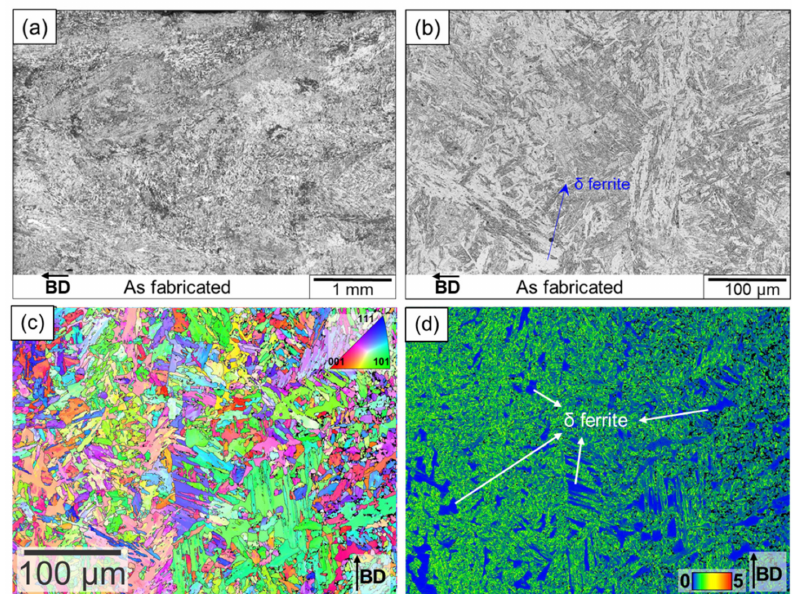
Figure 5. Characterization of the “Bottom” sample in an as-fabricated state ( a , b ). Optical micrographs showing a martensitic structure with delta ferrite stringers with the build direction from right to left of the “Side-Bottom” region ( c ). Inverse pole figure with build direction from bottom to top ( d ). Kernel average misorientation maps clearly demonstrating the presence of delta